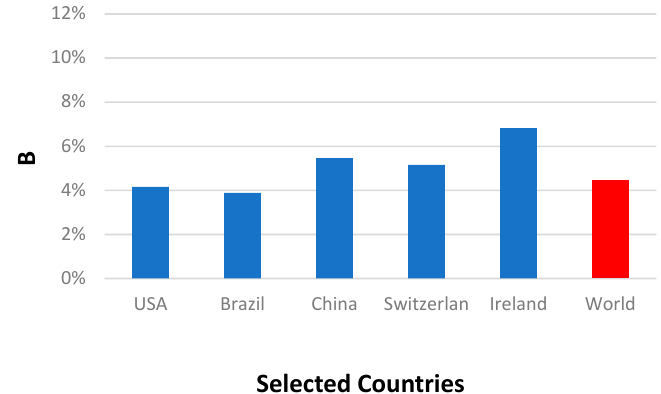
Figure 9. Infected cases per capita, A, for the selected countries of the world.